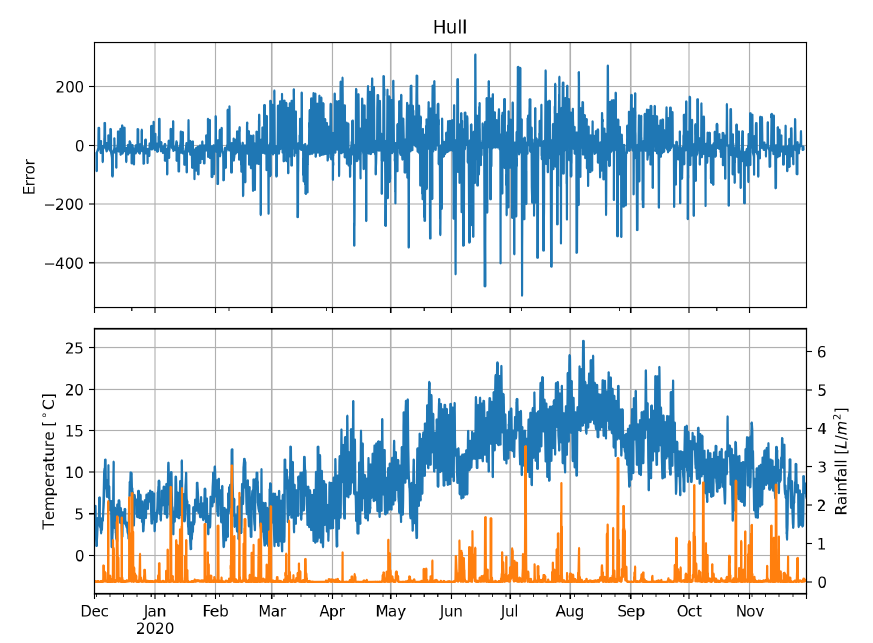
Figure 14. Error of LSTMconv Model and temperature/rainfall in Hull from 1 December 2019